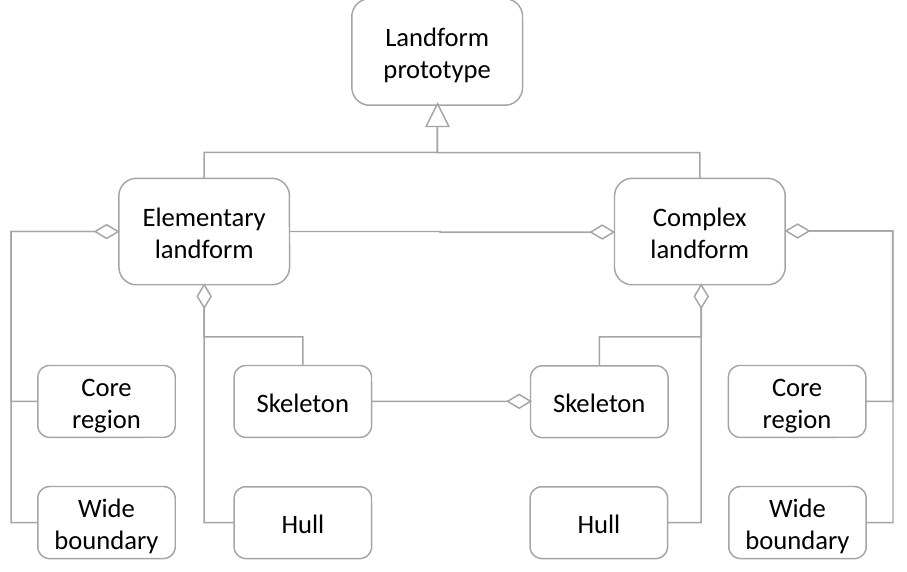
Figure 2. The proposed landform